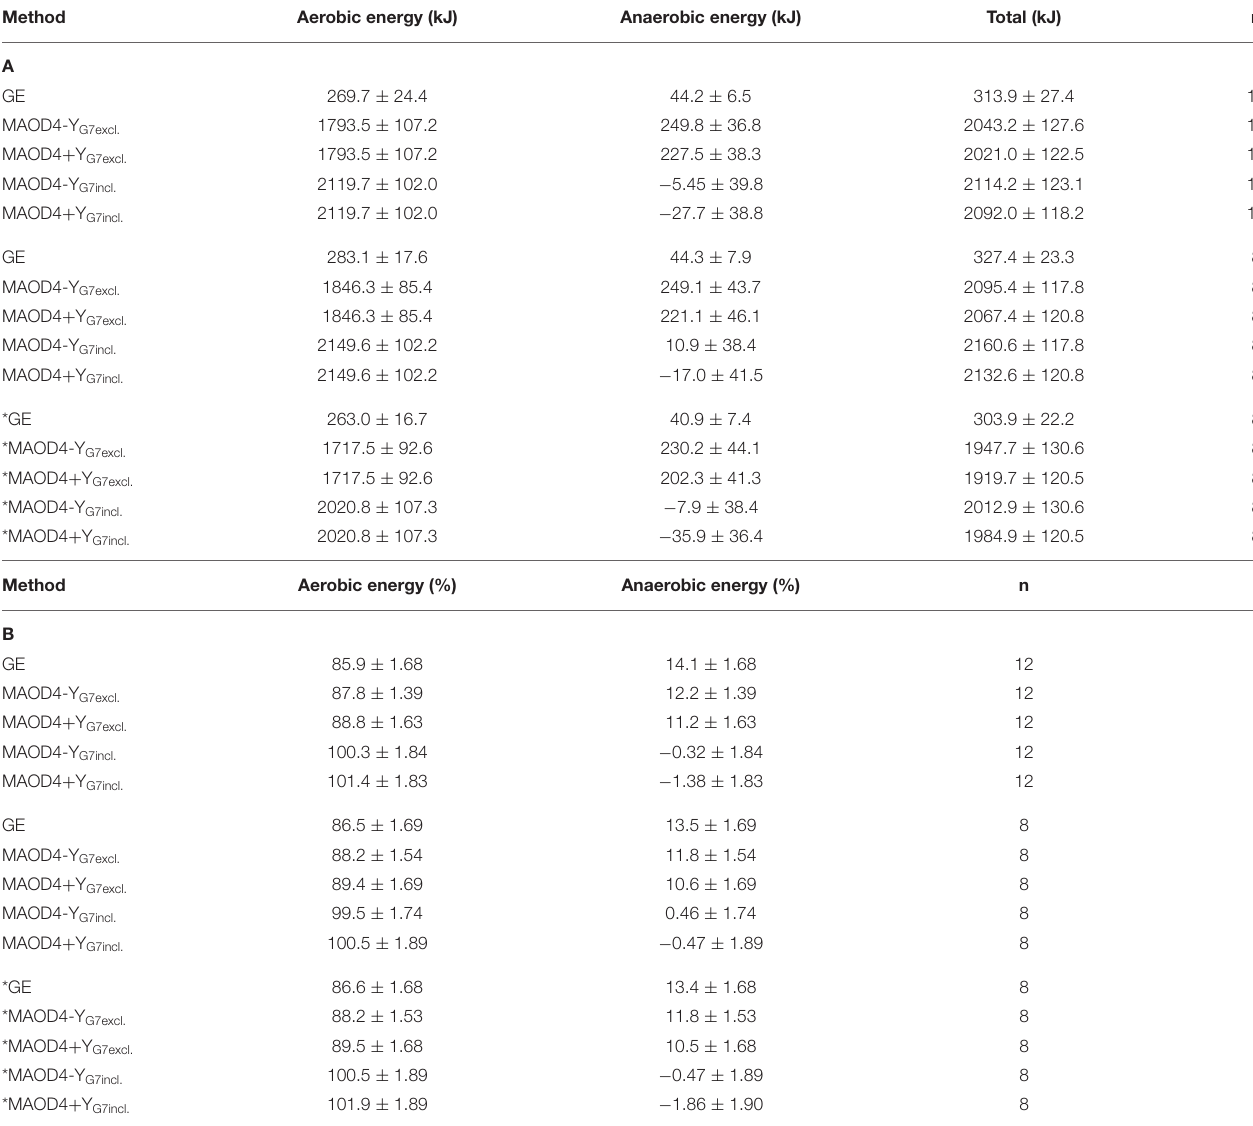
TABLE 2 | The average accumulated absolute (A) and relative (B) aerobic and anaerobic energy contributions during the simulated mass-start competition. A) Absolute energy contribution in mechanical terms for the GE method (kJ) and metabolic terms for the MAOD method (kJ). B) Relative energy contributions (%) of both methods.